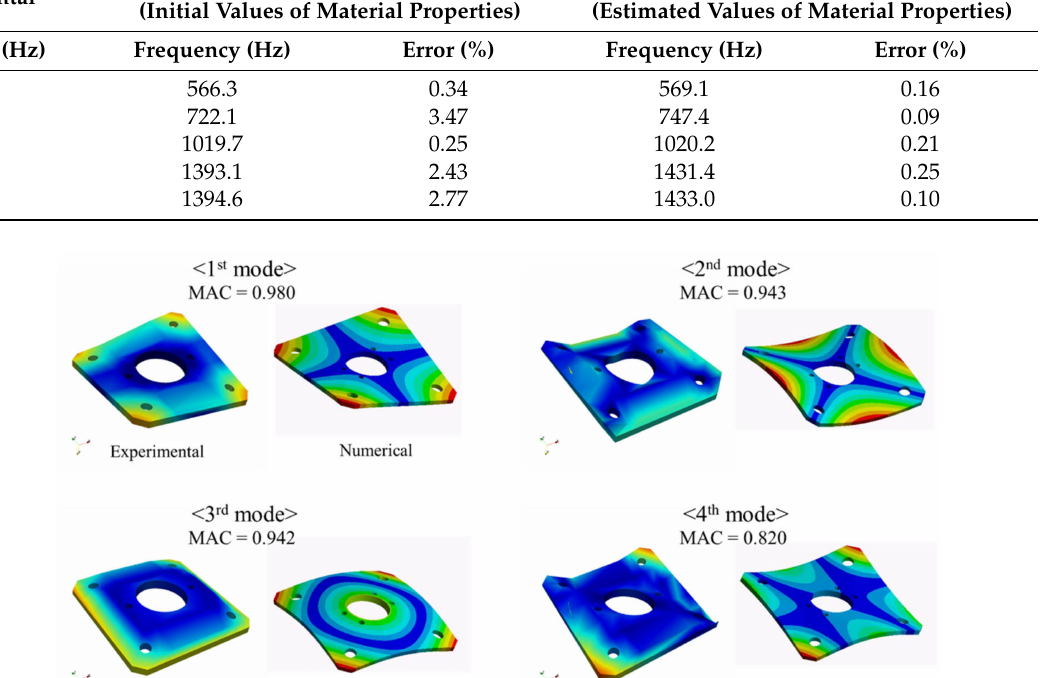
Figure 9. Comparison between experimental mode shapes and numerical mode shapes obtained with the estimated values of material